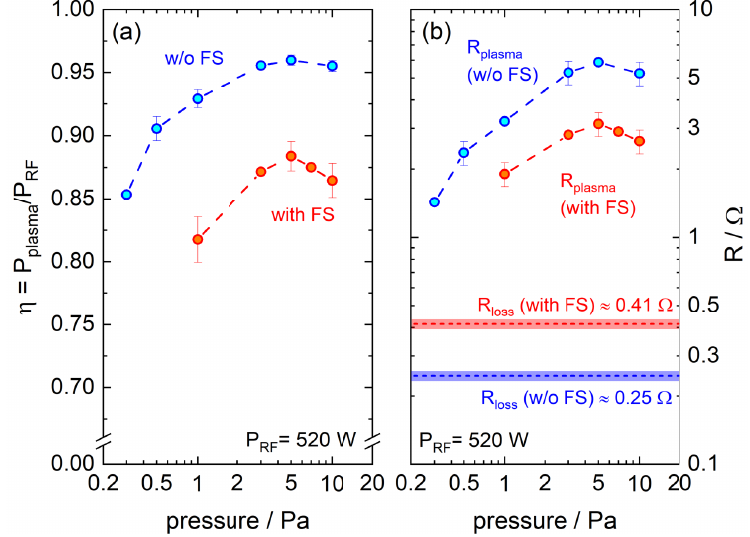
Figure 2. ( a ) RF power transfer efficiency of ICPs with and without Faraday shield and ( b ) corre- sponding plasma equivalent and loss resistances at varying